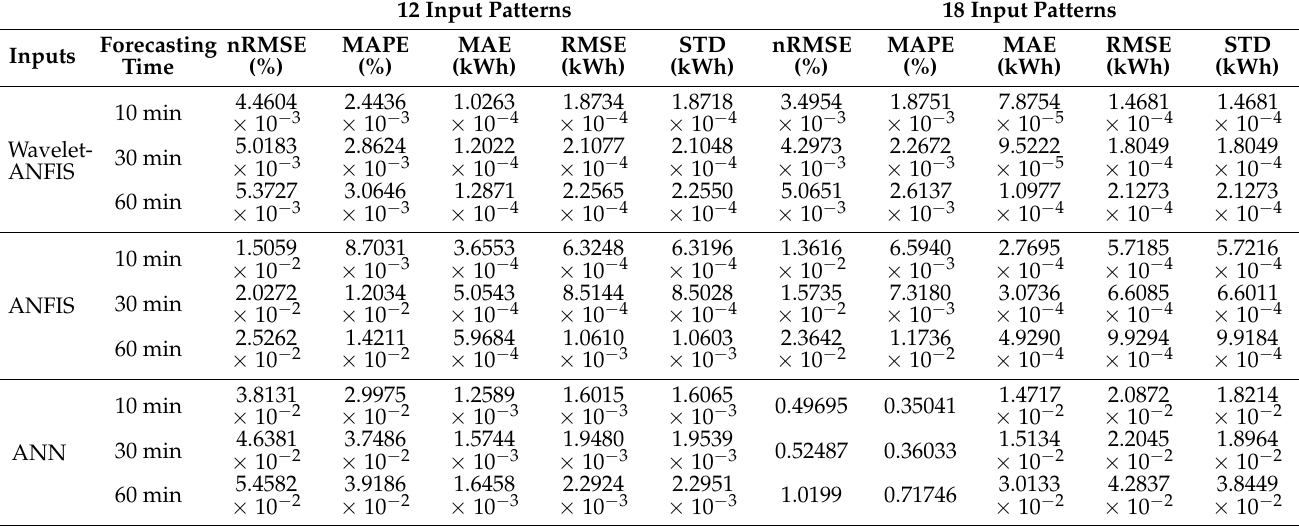
Table 3. The performance of the Wavelet-ANFIS compared with ANFIS and ANN